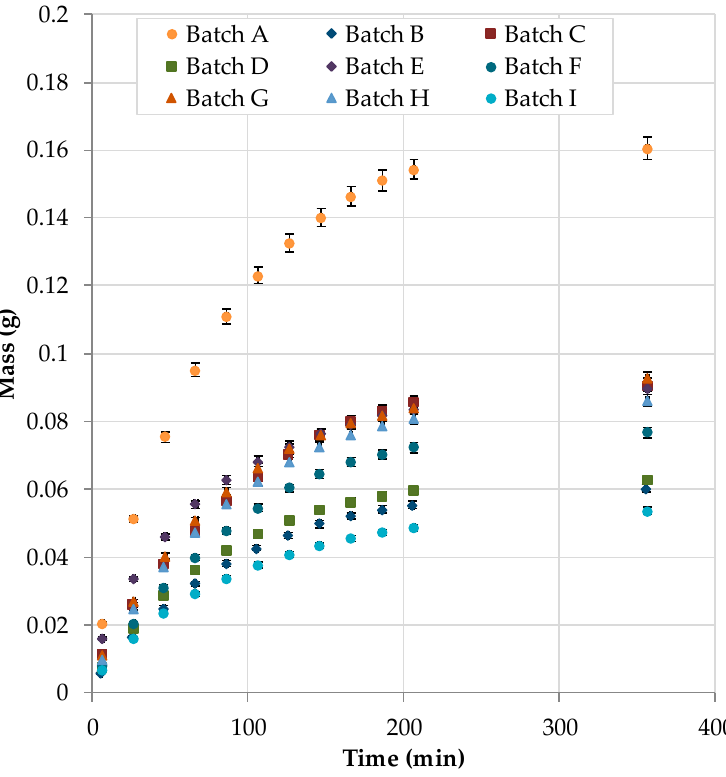
Figure 2. Percolation of the various hawthorn lots [49].